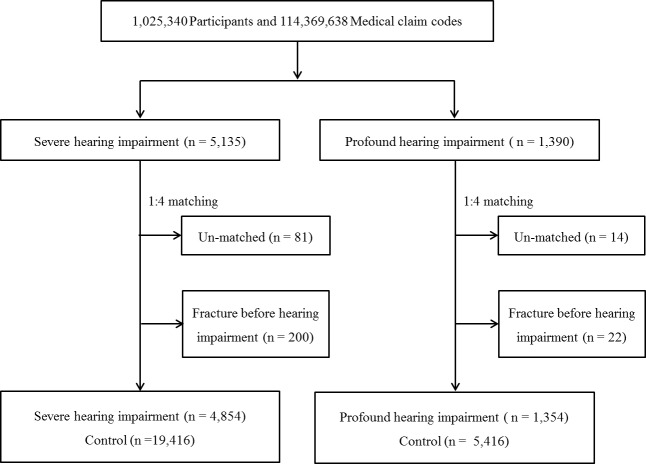
A schematic illustration of the participant selection process used in the present study.Out of 1,025,340 participants, 5,135 severe hearing-impaired and 1,390 profound hearing-impaired participants were selected. Hearing-impaired participants were matched 1:4 with a control group that did not have a hearing impairment diagnosis. Finally, 4,854 severe hearing impairment and 19,416 control participants were included as well as 1,354 profound hearing-impaired and 5,416 control participants.